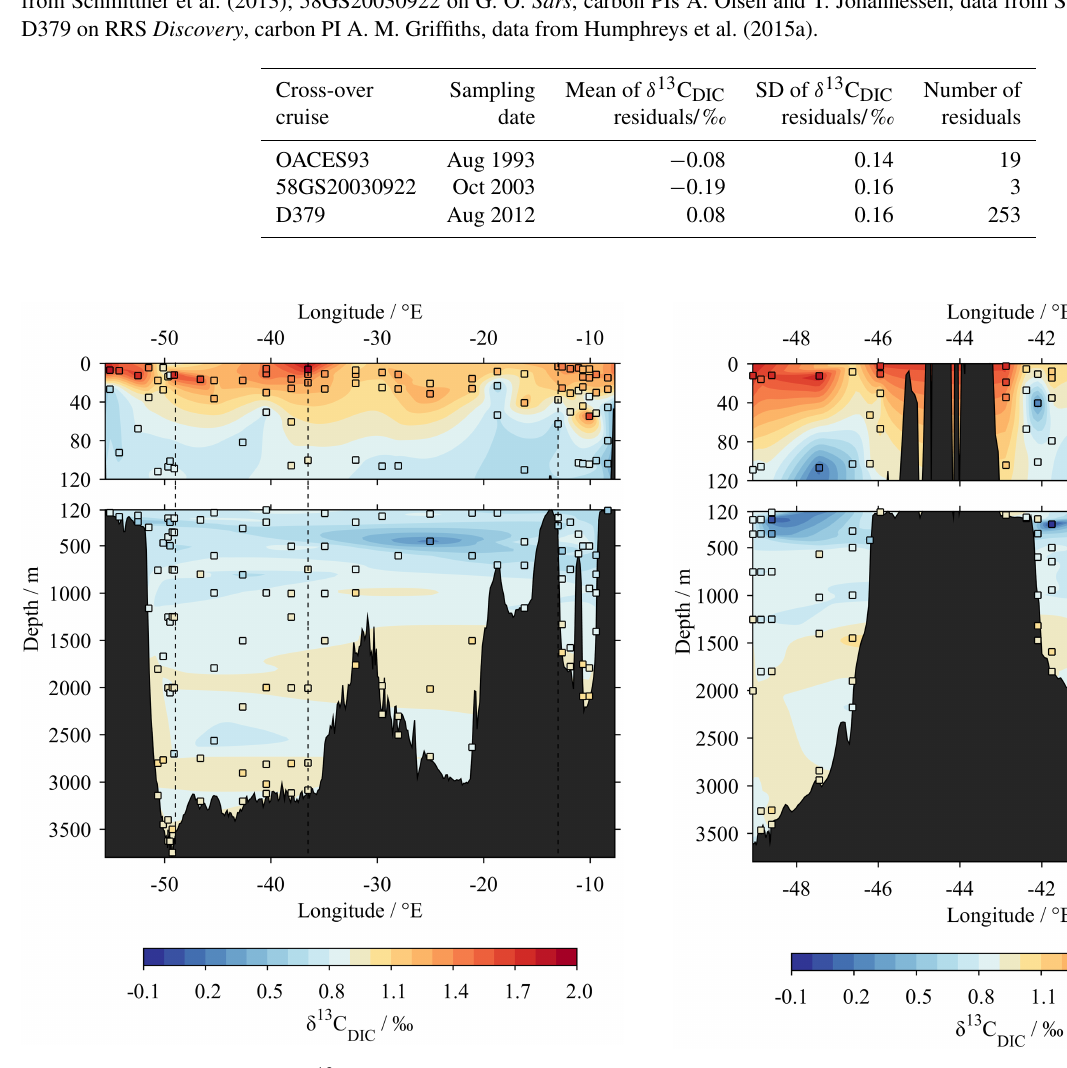
Figure 7. Zonal section of δ 13 C DIC results from this study, from west to east near southern Greenland (orange in Fig. 1). Coloured squares show actual sample locations and δ 13 C DIC val- ues. Bathymetry data are from the GEBCO_2014 grid, version 20150318,